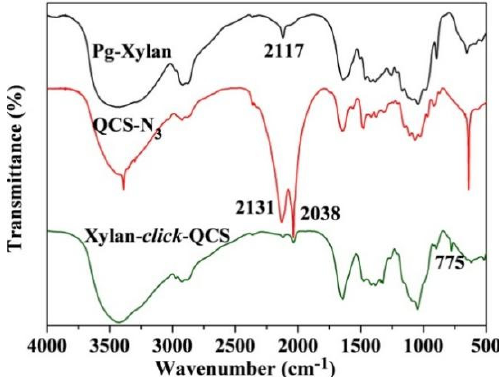
Figure 3. FT-IR spectra of Pg-xylan, QCS-N 3 and Xylan-click-QCS.